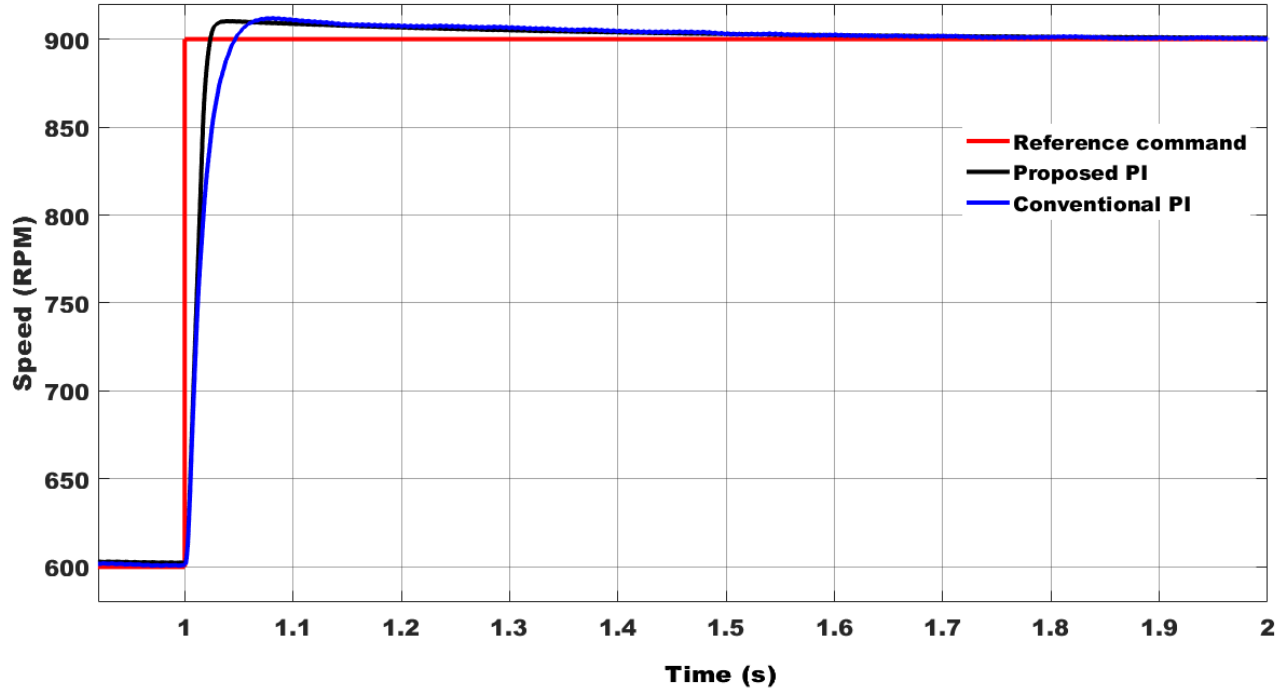
Figure 11. Comparison of robust tracking performance of SynRM drive under the step change of speed command.